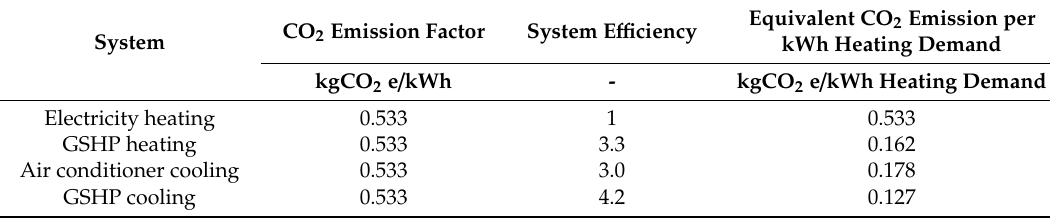
Table 2. CO 2 emissions factors for heating and cooling systems.